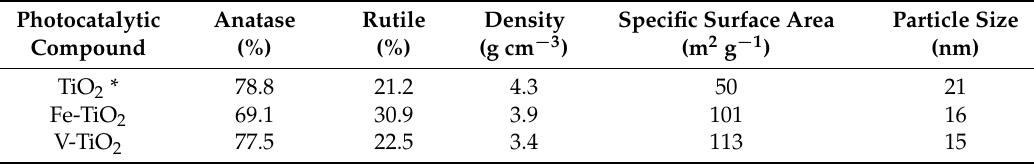
Table 2. Characteristics of the photocatalytic additives.